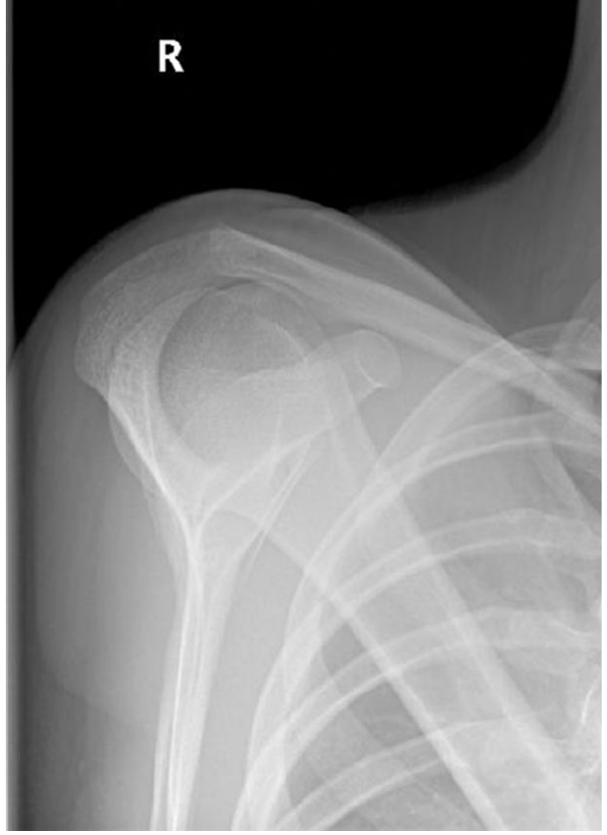
Figure 1. Clavicle shortening in Alexander projection, by overlap.